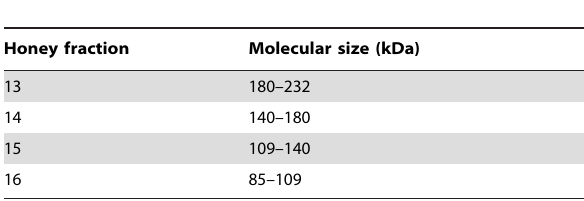
Table 3. Molecular size of fractions eluted from